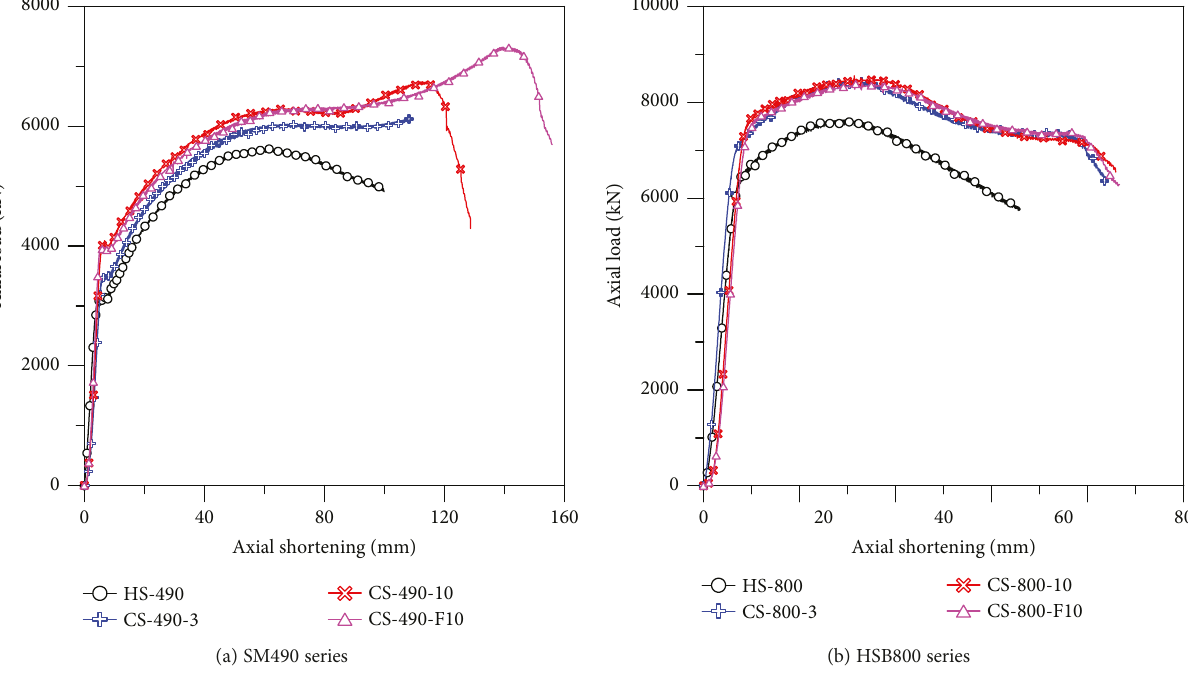
Figure 8: Load-displacement